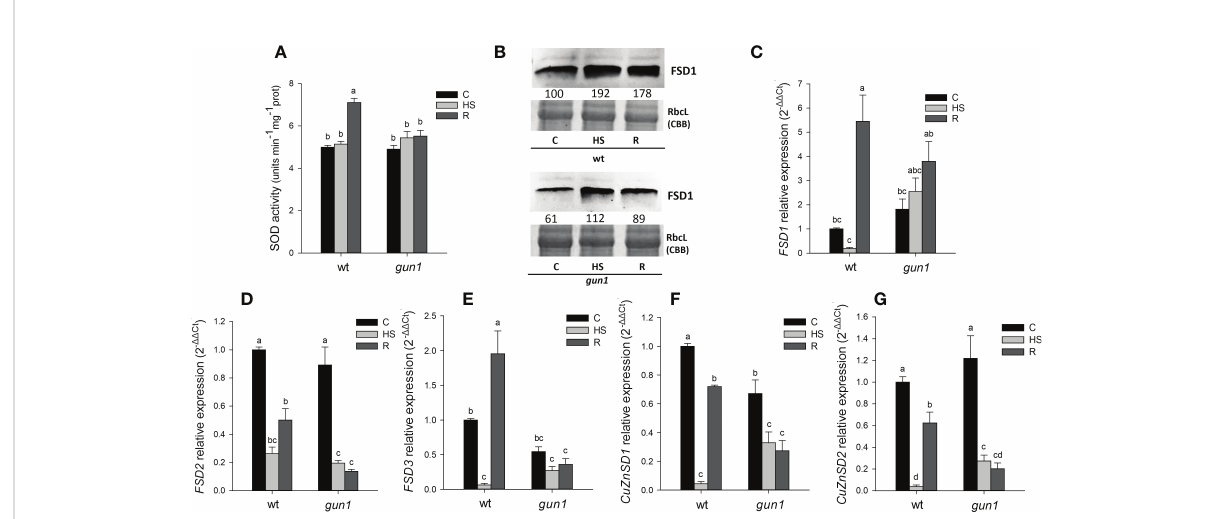
FIGURE 6 Superoxide dismutase (SOD) behavior in 15 days-old wt and gun1 plantlets, grown at control temperature (C) or subjected to Heat Stress (HS; 2 hours at 45°C), followed by short recovery (R; 3 hours at 22°C). (A) Total SOD activity; values are the means ± standard errors (SE) of fi ve independent experiments. Letters indicate signi fi cant differences obtained by one-way ANOVA test (P< 0.05). (B) Representative images from three independent experiments of FSD1 immuno-blotting; each well was loaded with 30 m g of proteins. Coomassie Brilliant Blue (CBB) staining of the gel served as a loading control. Quanti fi cation of signals (by Quantity One ® ) relative to the wt in control conditions (100%) is provided below the panel. Relative expression of (C) FSD1 , (D) FSD2 , (E) FSD3 , (F) CuZnSD1 (G) and CuZnSD2 . The expression level of SOD genes was normalized to that of Ubiquitin10 (At4g05320) and Actin8 (At1g49240) as internal references. For each sample, gene expression was related to the wt in control conditions (C). Values are expressed as means ± SE from three independent experiments, with three technical replicates for each experiment. Different letters indicate signi fi cant differences obtained by one-way ANOVA test (p< 0.05).